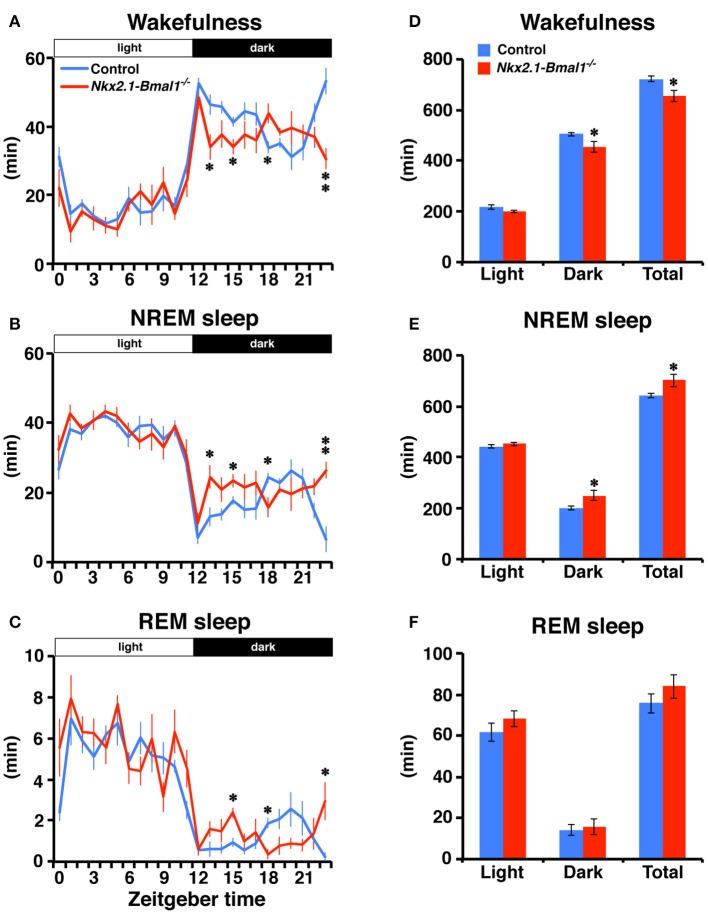
Temporal pattern of sleep-wakefulness during the dark phase is altered in Nkx2.1-Bmal1−/
−
mice. (A–C) Hourly plots of time spent in wakefulness (A), NREM sleep (B), or REM sleep (C) in LD. (D–F) Time spent in wakefulness (D), NREM sleep (E), or REM sleep (F) during 12-h light phase (Light), 12-h dark phase (Dark), and 24-h day (Total). Values are mean ± SEM. n = 6 for control, n = 4 for Nkx2.1-Bmal1−/− mice. *p < 0.05; **p < 0.01 by a Tukey-HSD post-hoc. The p-values calculated by two-way repeated measures ANOVAs are: (A) the effect of genotype, F(1, 184) = 9.52, p = 0.015; the effect of time, F(23, 184) = 31.71, p < 0.001; and the interaction between genotype and time, F(23, 184) = 2.60, p < 0.001; (B)
F(1, 184) = 5.94, p = 0.041; F(23, 184) = 29.30, p < 0.001; F(23, 184) = 2.60, p < 0.001; (C)
F(23, 184) = 24.36, p < 0.001; F(23, 184) = 2.26, p = 0.02; (D) the effect of genotype, F(1, 8) = 9.52, p = 0.015; the effect of time (Light vs. Dark), F(1, 8) = 559.33, p < 0.001; and the interaction between genotype and time, F(1, 8) = 2.04, p = 0.191; (E)
F(1, 8) = 5.94, p = 0.041; F(1, 8) = 567.63, p < 0.001; F(1, 8) = 4.17, p = 0.075; (F)
F(1, 8) = 1.24, p = 0.299; F(1, 8) = 155.87, p < 0.001; F(1, 8) = 0.41, p = 0.538.